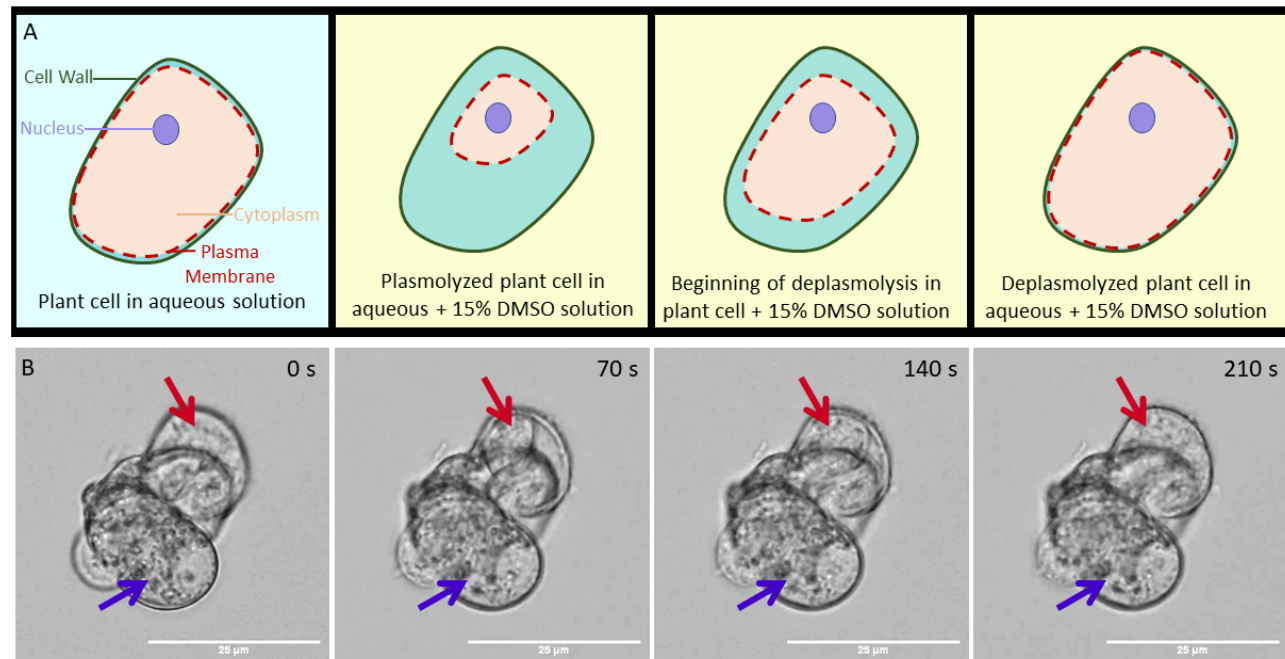
Figure 1. Panel A: Cartoon representation of a cell undergoing plasmolysis (the pulling away of the red dashed plasma membrane from the green cell wall) and deplasmolysis (the moving of the cell membrane back to cell wall) as it is exposed to a 15% DMSO in water solution (yellow background). Panel B: Brightfield microscopy images showing a small cluster of rice suspension cells 0, 70, 140, and 210 s after exposure to 15% aqueous DMSO. Red arrow: a cell that completely plasmolyzed after 70 s and deplasmolyzed after 210 s. Purple arrow: a cell that did not appear to respond to the 15% DMSO in water solution.